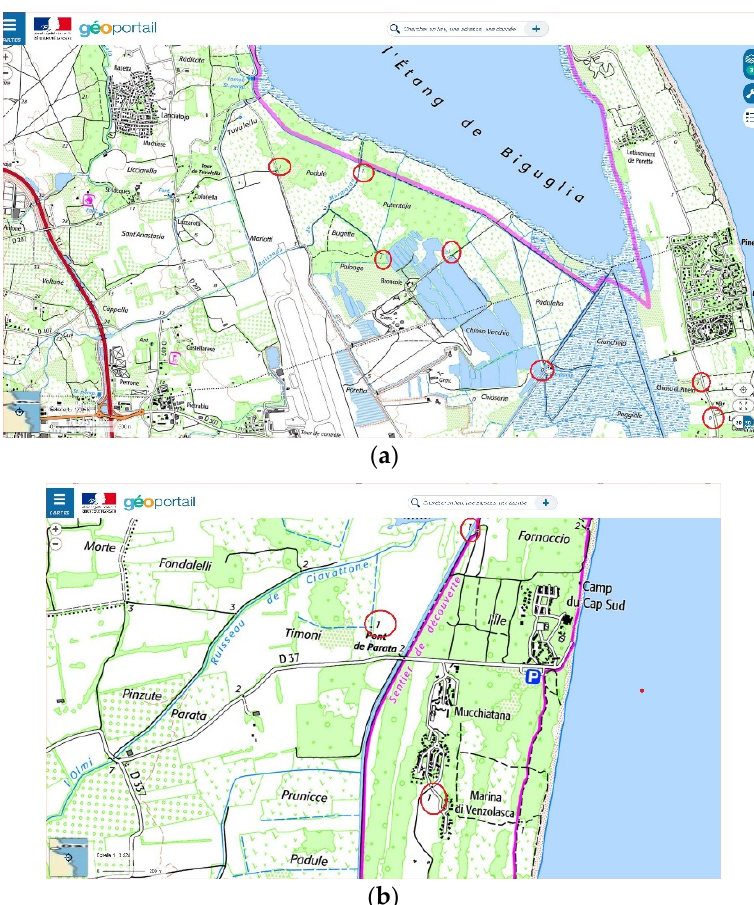
Figure 10. ( a ) and ( b ). Bastia 1:5000 scale map, the red circle underline the altitude showing a excellent agreement with the Map 4 Bastia.